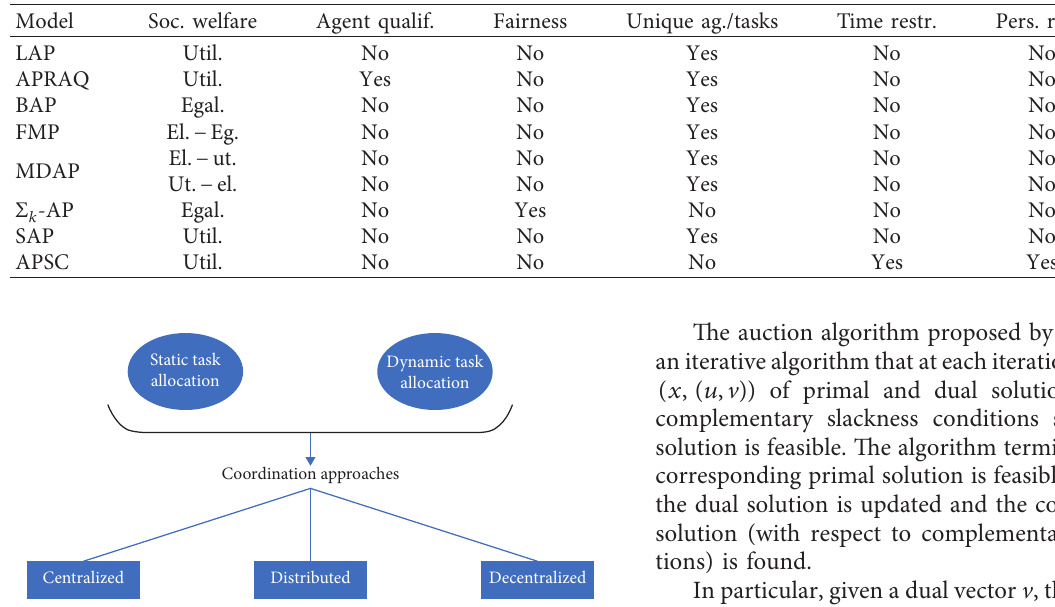
Figure 2: Coordination approach framework for task